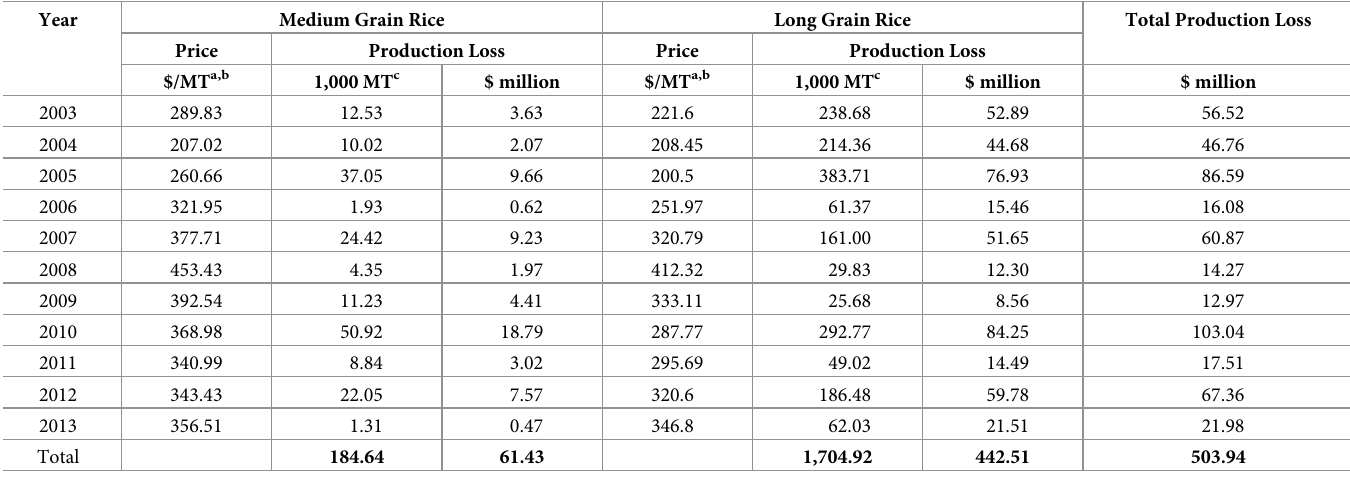
A total of 315 county/parish BPB occurrences from 2003 to 2013 were estimated under the 1˚C warming scenario, which is an increase of 94% from the actual observed temperatures. Table 3 indicates that total losses under the 1˚C warming scenario increase to 503.94 million USD from 2003 to 2013, averaging 45.81 million USD in economic losses per year. The 1˚C warming scenario suggests that the increase in BPB and its subsequent yield losses would have Table 3. Estimated total losses from bacterial panicle occurrences given an uniform 1˚C increase in temperature in the Lower Mississippi Delta Region: